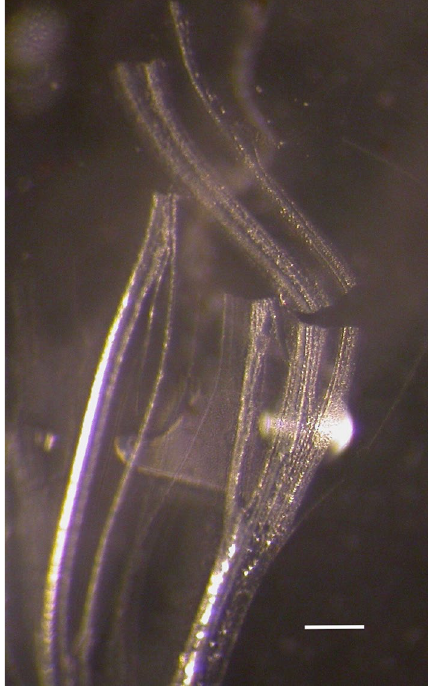
Figure 8. Sheets and tubes of hemoglycin in watch glass prior to crystallography loop pick-up. Scale bar 100 µm. Nikon E4500 camera mounted on a Leica MZ8 zoom